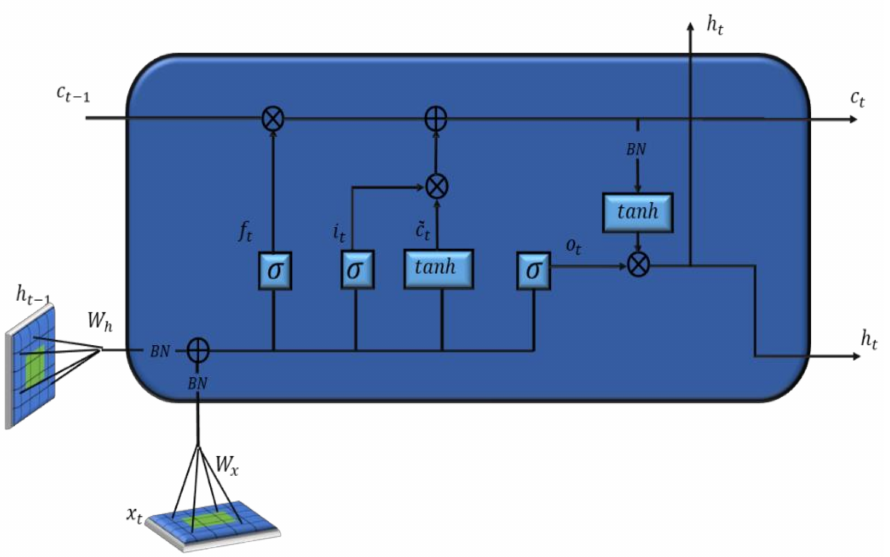
Figure 5. The internal structure of ConvLSTM